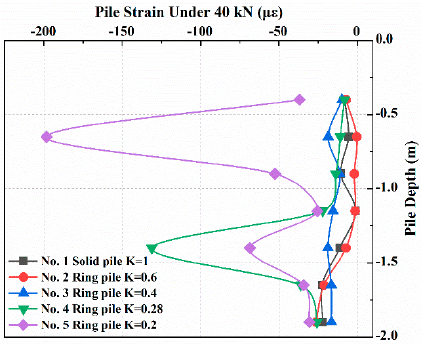
Figure 10. Pile strain under 40 kN.